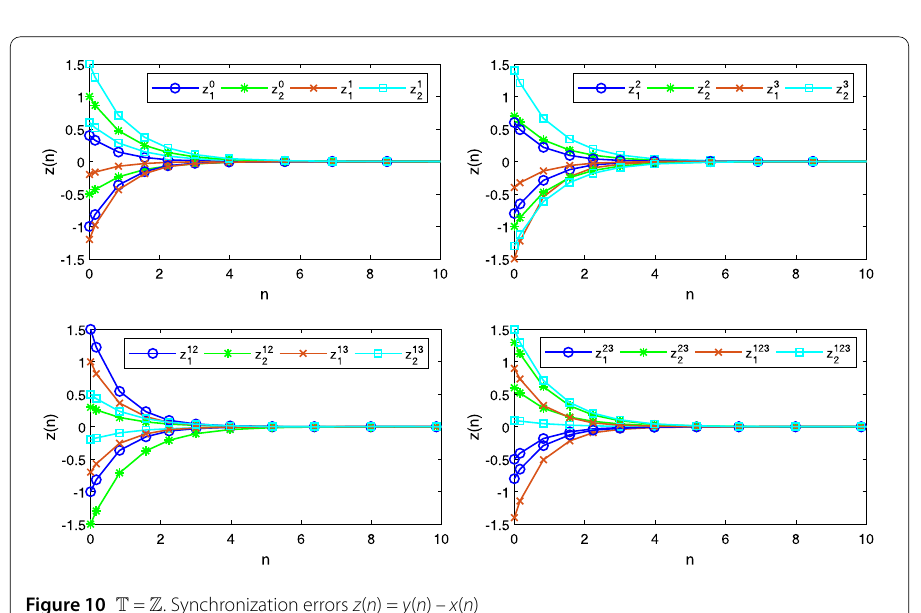
Figure 10 T = Z . Synchronization errors z ( n ) = y ( n ) – x ( n